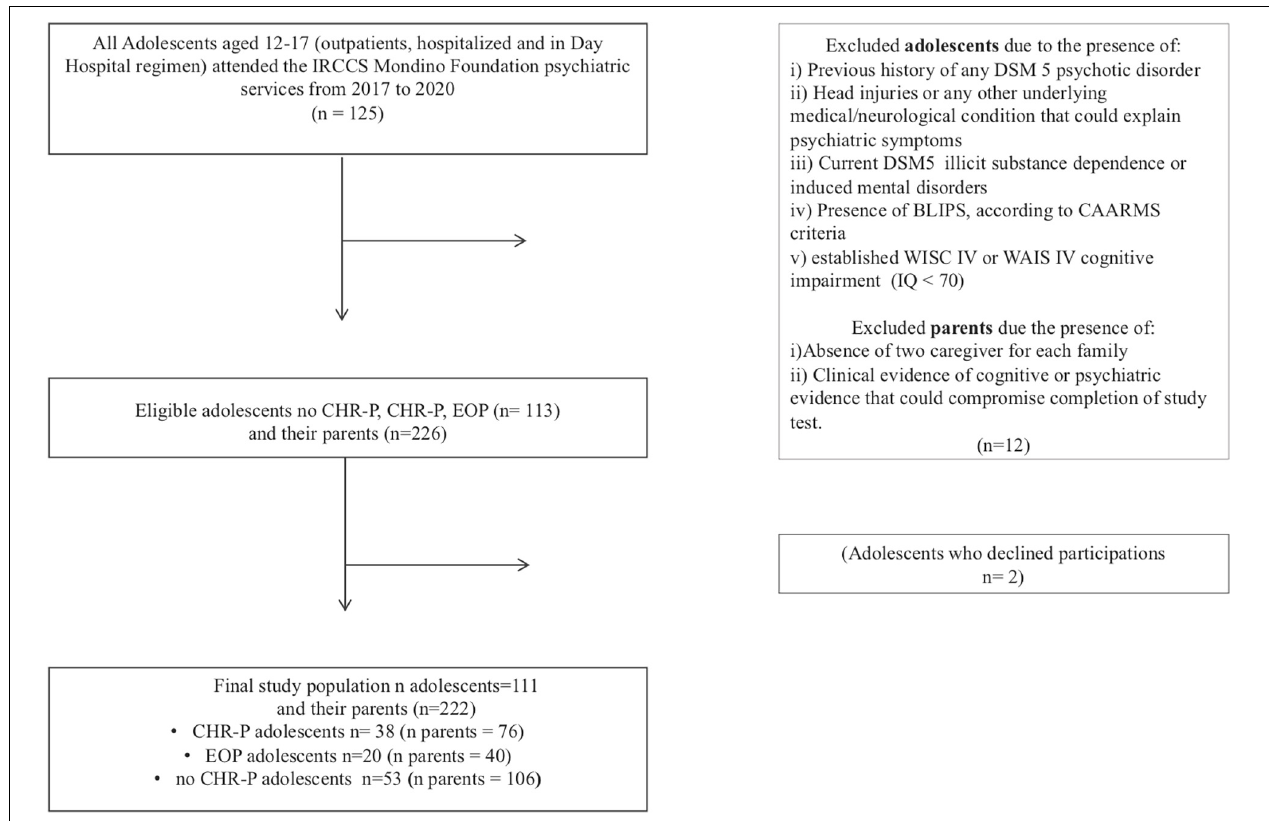
FIGURE 1 | Flow chart of the study